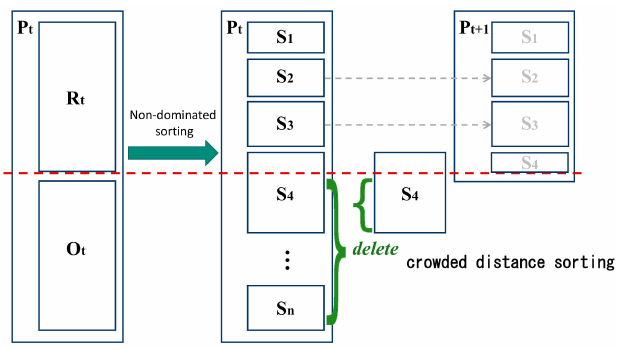
Figure 2. Schematic diagram of non-dominated